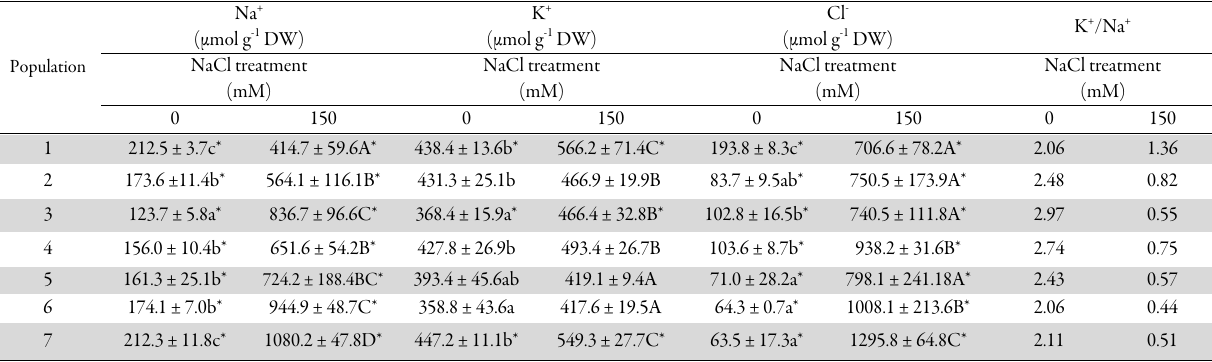
Fig. 3. Photosynthetic pigments contents in seedling needles of the seven studied populations of Romanian larch, expressed in mg g -1 DW. (A) chlorophyll a (Chl a); (B) chlorophyll b (Chl b); (C) carotenoids (Caro). Values shown are means ± SE (n = 5). Different letters over the bars (lower case for controls and capital letters for salt-stressed plants) indicate significant differences between different populations according to Tukey test (α = 0.05). Asterisks (*) indicate significant differences between salt- treated and control seedlings of the same population. Populations are given number codes according to Table 1 Table 2. Ion contents (Na + , K + , Cl - ) and K + /Na + ratios in seedling needles of the seven populations of Romanian larch. Values shown are means ± SE (n = 5). Different letters (lower case for controls and capital letters for salt-stressed plants) in a column indicate significant differences between different populations according to Tukey test (α = 0.05). Asterisks (*) indicate significant differences between salt-treated and control seedlings of the same